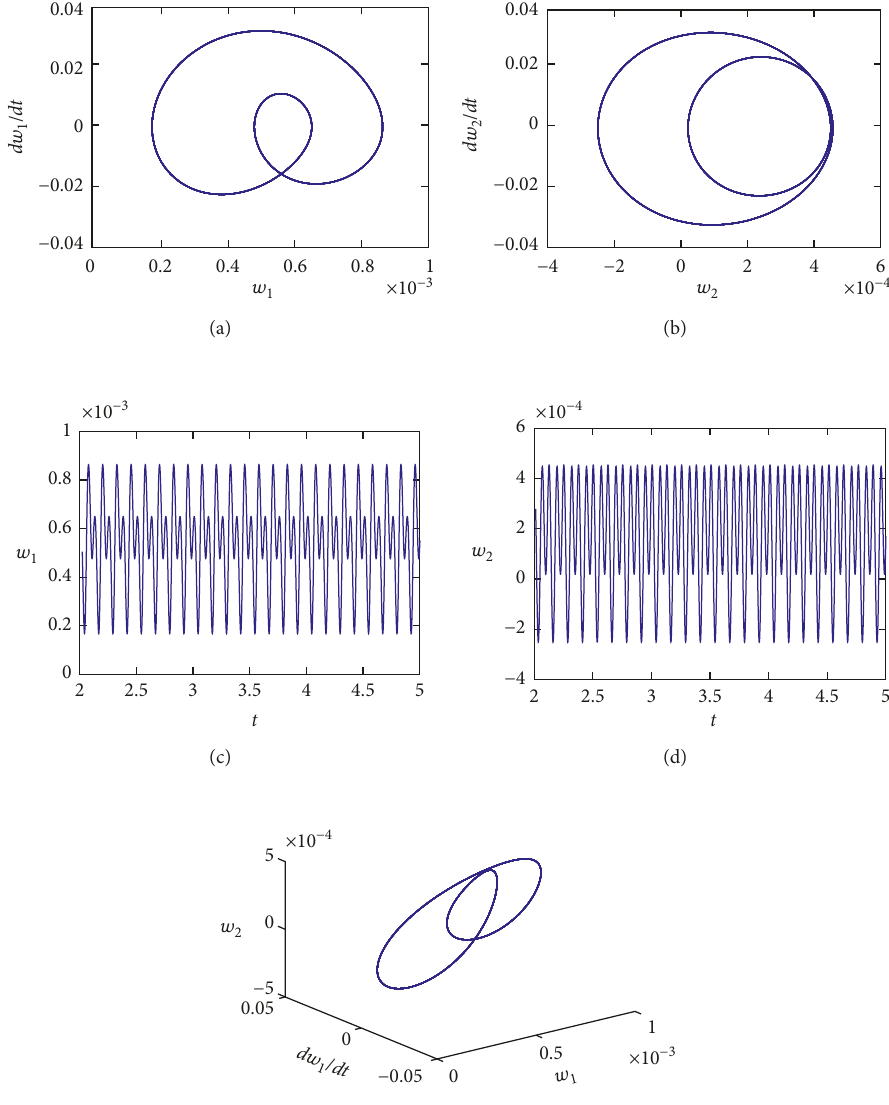
Figure 6: Period-2 motion of the cantilever honeycomb sandwich plate.